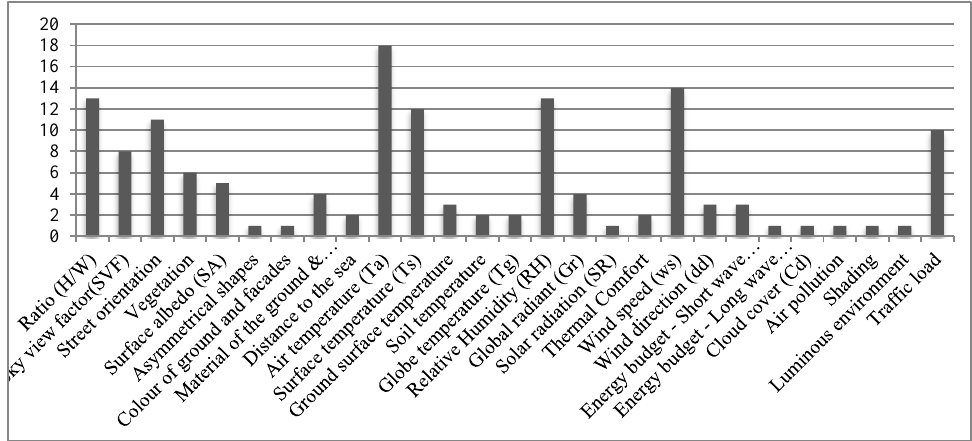
Fig. 3. Depth of Citation (DoC) of Street Geometry Factors in urban climatology